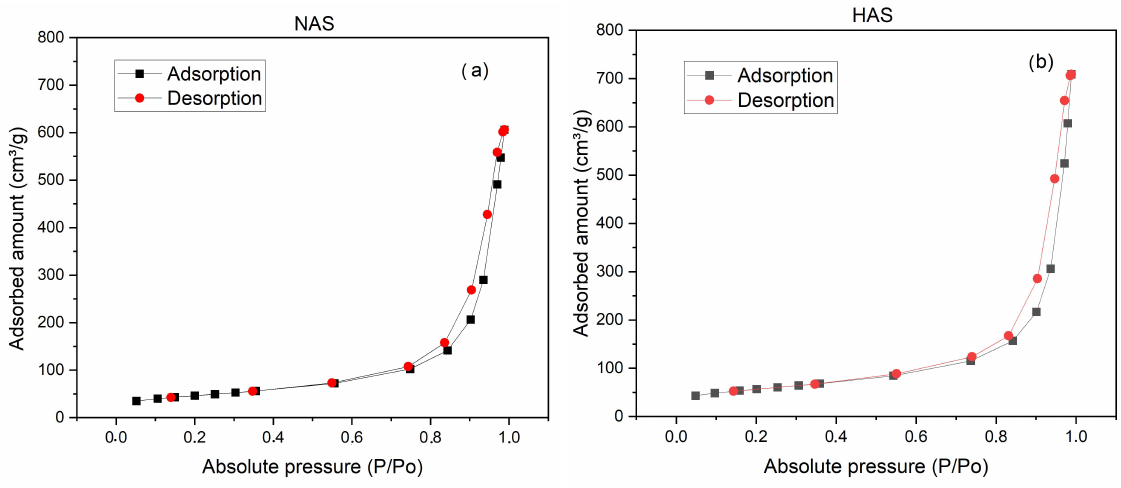
Figure 6. N 2 adsorption—desorption isotherms of clays ( a ) NAS and ( b ) HAS.